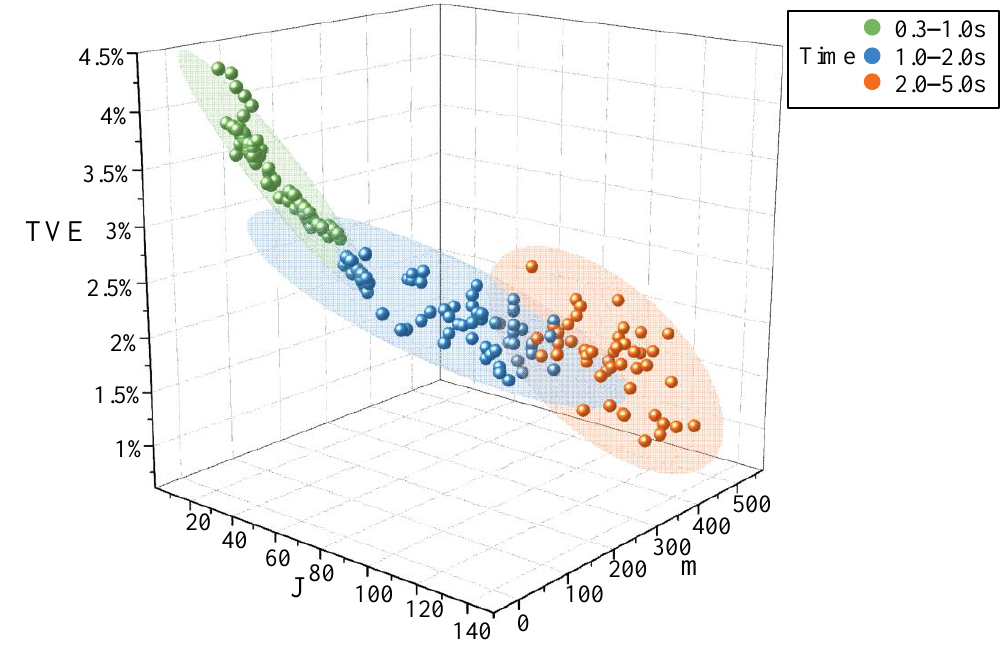
Figure 1. Reconfiguration effect and running time range with parameters.